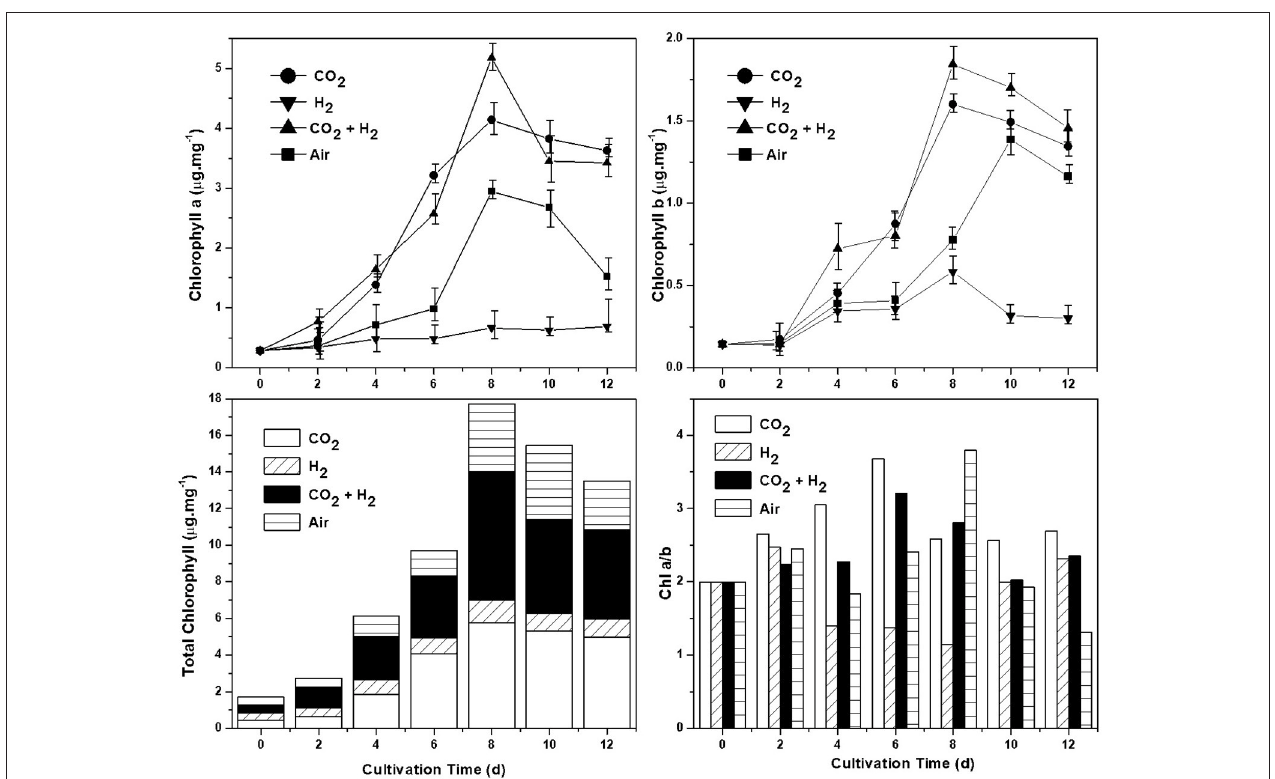
FIGURE 3 | Chlorophyll estimation under different gas conditions determining the photosynthetic activity. Chlorophyll a ( µ g.mg − 1 ), chlorophyll b ( µ g.mg − 1 ), Chlorophyll a/b ratio, and total chlorophyll ( µ g.mg − 1 ) are depicted clockwise from the top left.